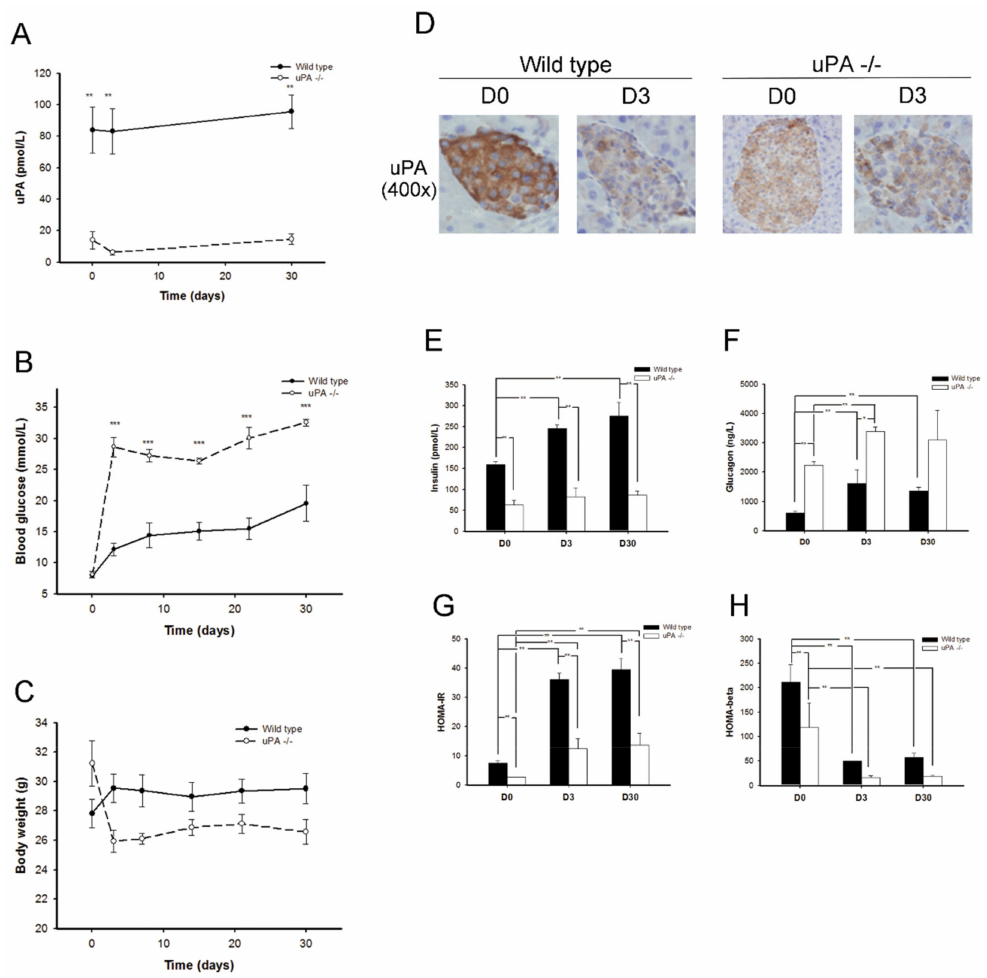
Figure 1. Changes in uPA, blood glucose, body weight, uPA expression on islet, insulin, glucagon, insulin resistance (HOMA-IR), and insulin secretion (HOMA- β ) before and after development of type 2 diabetes mellitus (T2DM) in both wild-type and uPA- / - mice (n ≥ 4). ( A ) The uPA levels in wild-type (solid line) mice were significantly higher than those in uPA- / - (dashed line) BALB / c mice. ** p < 0.01. ( B ) D0, blood sugar levels in both uPA- / - and wild-type mice were similar. After induction, blood glucose in uPA- / - BALB / c mice was significantly higher than in wild-type mice. *** p < 0.001. ( C ) The body weight in both wild-type and uPA- / - BALB / c mice showed no significant di ff erence. ( D ) The expressions of uPA on islet before and after induction of T2DM were compared by immunohistochemical stain. In wild-type mice, uPA expression obviously decreased after induction of T2DM. The low expressions of uPA persisted both before and after induction in uPA- / - mice. ( E ) The insulin levels in wild-type mice were significantly higher than in uPA- / - mice. With the high-fat diet, insulin levels increase progressively in both wild-type and uPA- / - mice. ( F ) The glucagon levels declined gradually, along with elevation of insulin levels in wild-type and uPA- / - mice. ( G ) The HOMA-IR in wild-type mice was significantly higher than in uPA- / - mice. With a high-fat diet, the HOMA-IR increases significantly and progressively in both wild-type and uPA- / - mice. ( H ) The HOMA- β in uPA- / - mice was lower than in wild-type mice. After induction, the HOMA- β significantly decreases in both wild-type and uPA- / - mice. ** p < 0.01 (Kruskal–Wallis H